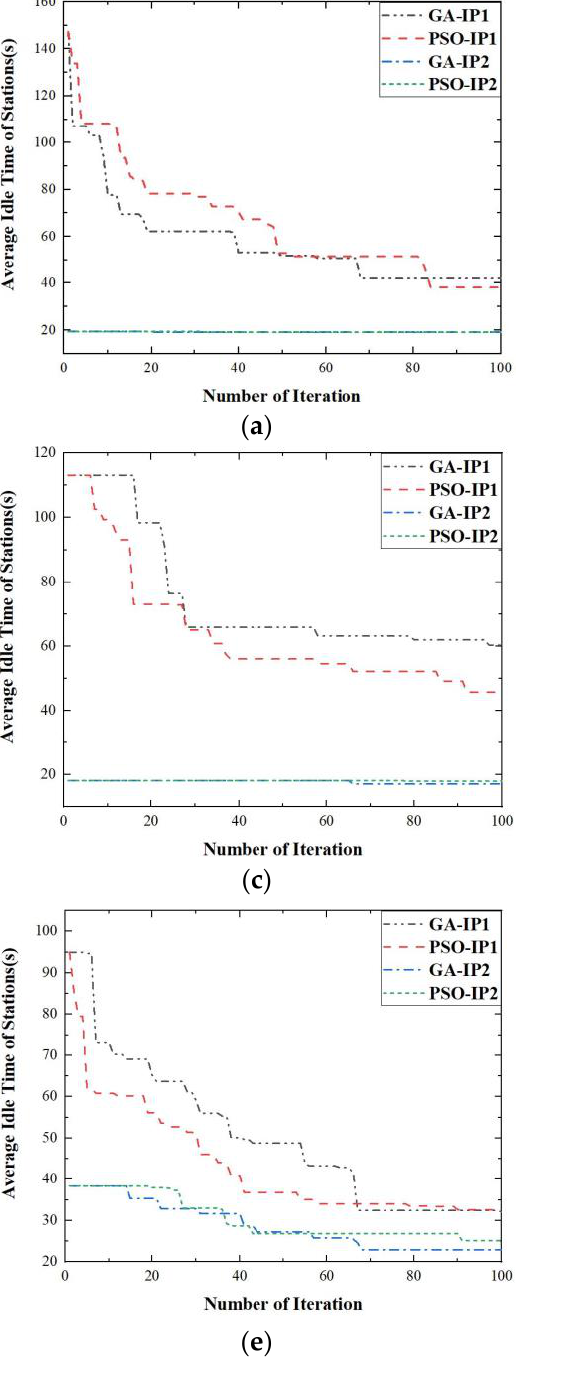
Figure 6. The graph of 100 iterations of GA-IP1, PSO-IP1, GA-IP2, PSO-IP2. ( a ) The test samples is the first set of test samples. ( b ) The test samples is the second set of test samples. ( c ) The test samples is the third set of test samples. ( d ) The test samples is the fourth set of test samples. ( e ) The test samples is the fifth set of test samples. ( f ) The test samples is the sixth set of test samples.